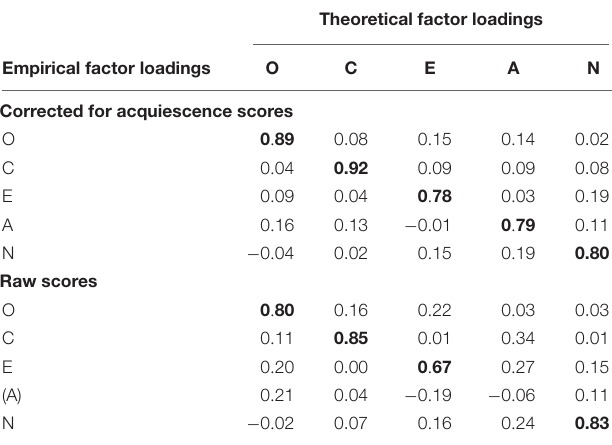
TABLE 4 | Conceptual congruency coefficients: Correlations of the empirically observed loadings on the five factors with a priori theoretical (ideal) loadings (1 and 0) for (a) scores corrected for acquiescence (upper half) and (b) uncorrected raw scores (lower